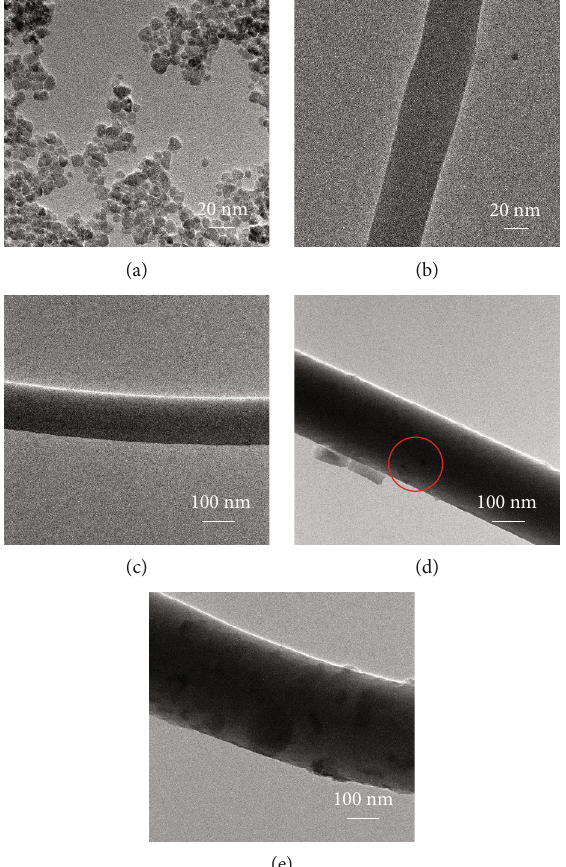
Figure 3: HR-TEM images of (a) ZnO nanoparticles and PVA/ZnO nano fi bers with di ff erent relative concentrations of ZnO NPs: (b) 0%, (c) 1%, (d) 4%, and (e) 7%.